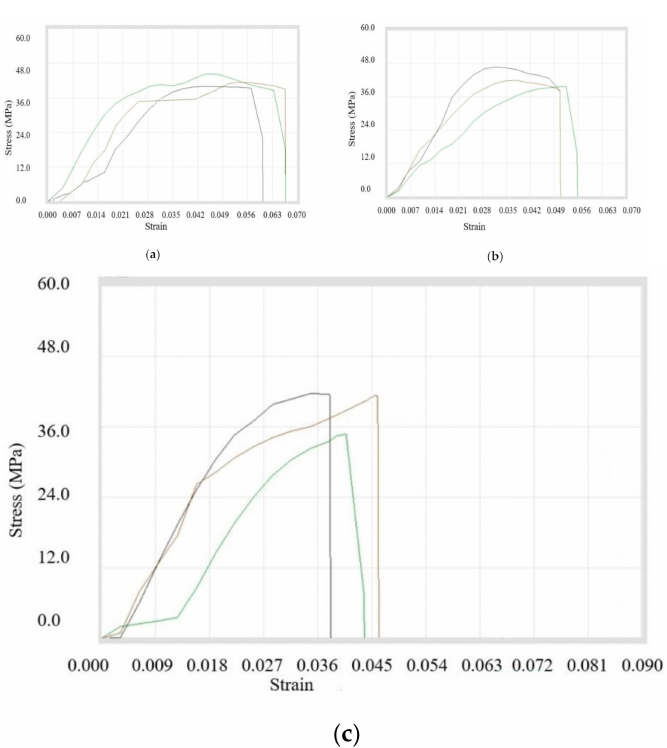
Figure 10. Stress–strain Curves for ( a ) C4 , ( b ) C9 , and ( c ) C10 filament